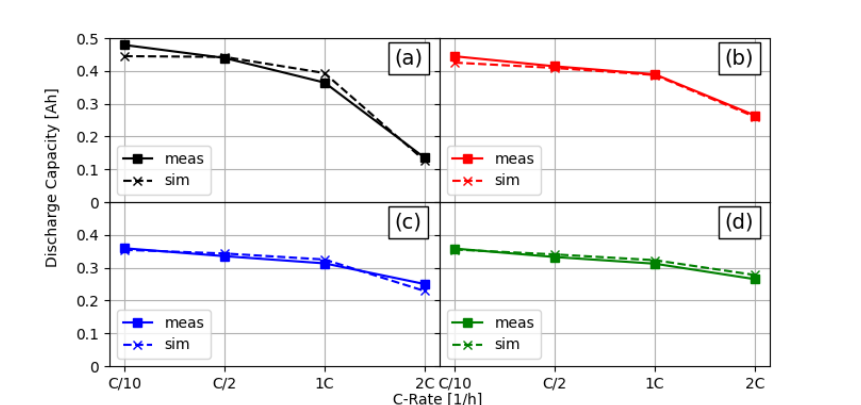
Figure 3. Comparison of measured and simulated discharge capacities for different C-rates and linear structured cell setups. ( a ) Unstructured reference cell, ( b ) structured anode (80µm channels and 300µm pitch), ( c ) structured cathode (60µm channels and 300µm pitch), and ( d ) both electrodes structured (80µm anode and 60µm cathode channels, both with 300µm